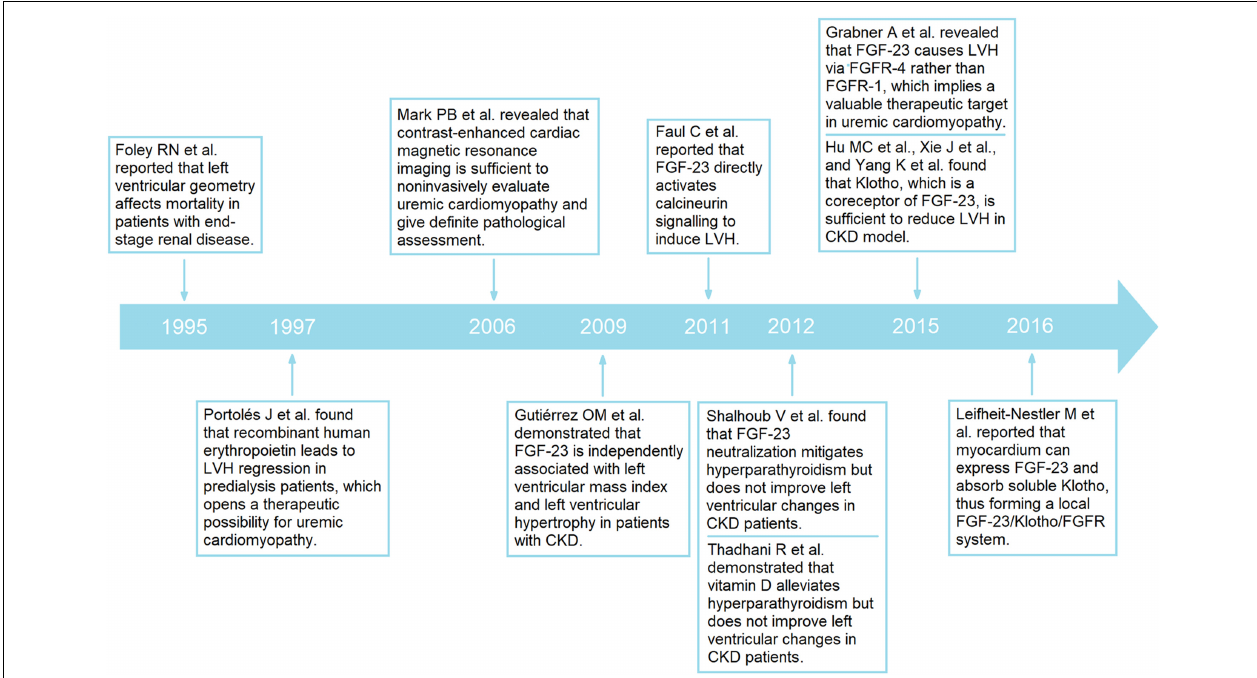
FIGURE 7 | Major achievements in the uremic cardiomyopathy